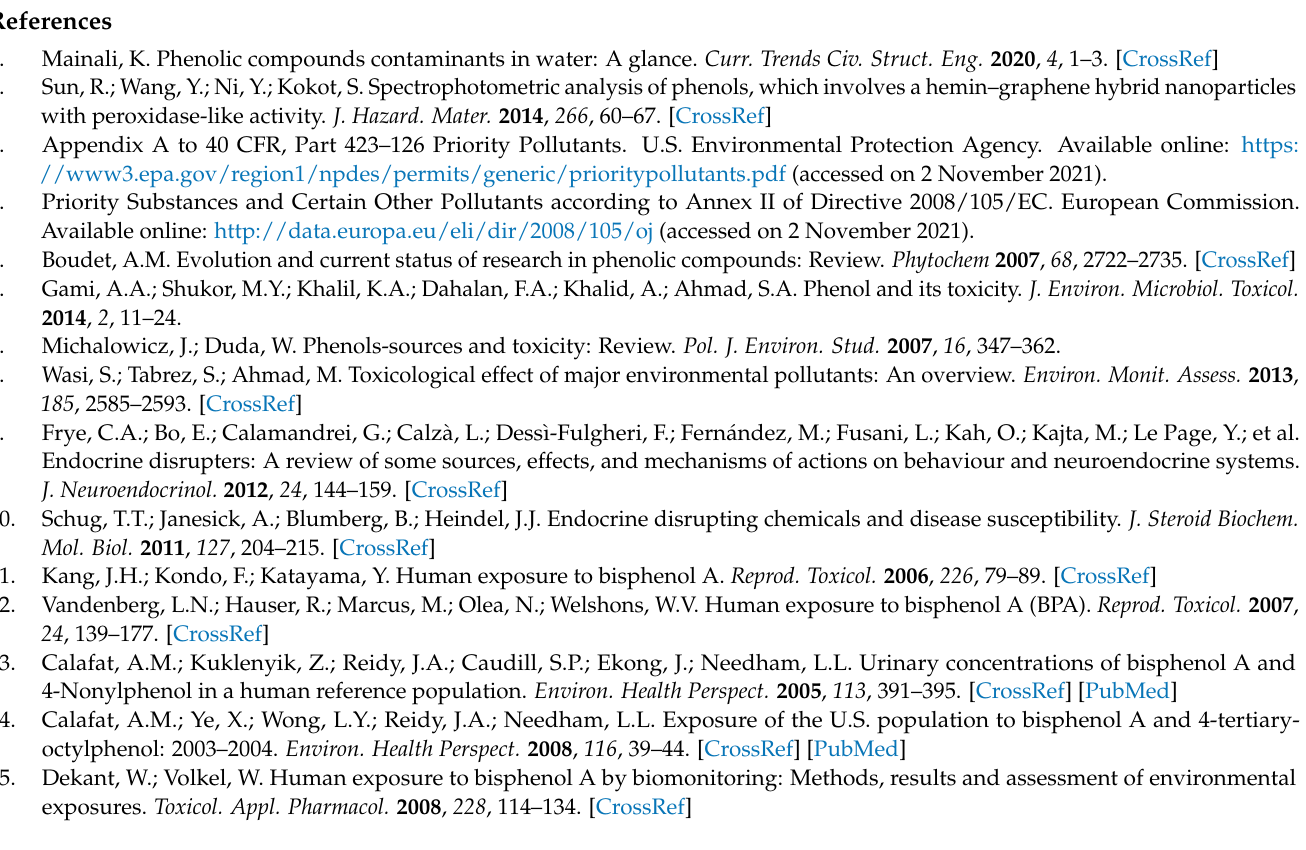
Table S2: Relevant working parameters for the optical sensors for the determination of phenolic compounds in environmental applications discussed in the present